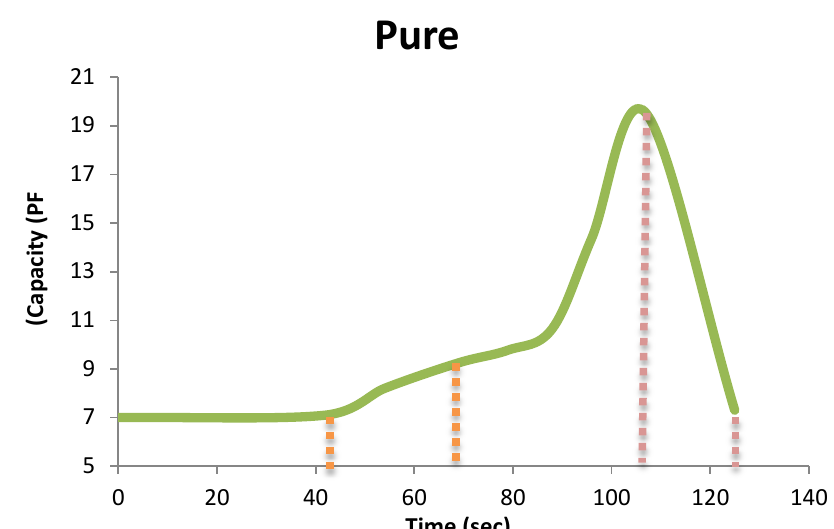
Fig.9: Response time and recovery time for PANI humidity sensor.